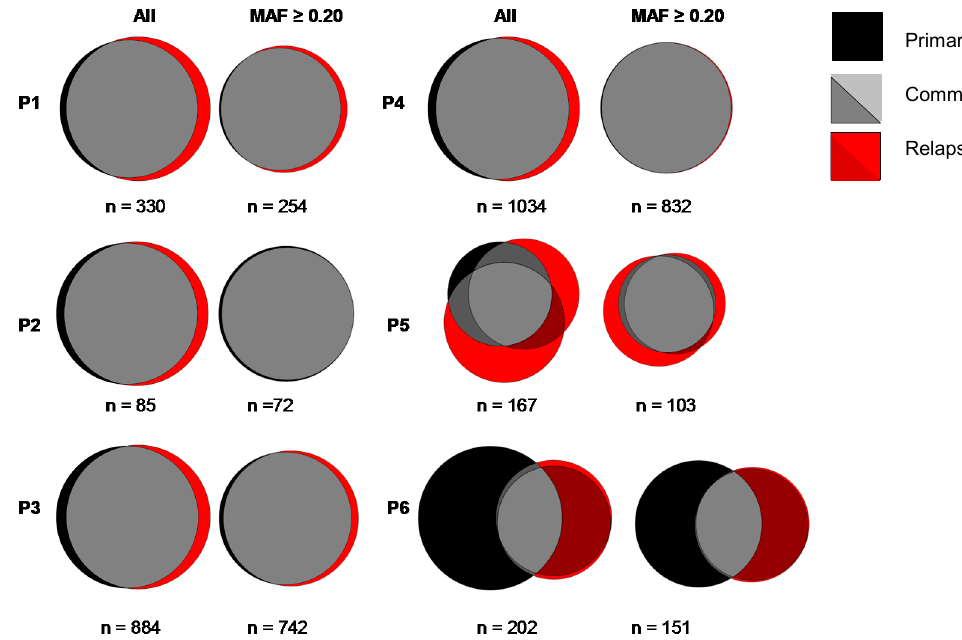
Figure 2. Venn diagrams showing for each individual patient (P1–6) the overlap in mutations between primary and paired relapse tumor samples. Left panels are Venn diagrams for all mutations (all), and right panels are Venn diagrams for mutations with a mutant allele frequency (MAF) ≥ 0.2. The total numbers of mutations per patient are depicted below each diagram. The size of the relapse diagram is proportional to the primary sample. In the patients with two biopsies at relapse (P5 and P6), the concordance between the novel mutations in the relapse samples was 45.3% and 89.2%, indicative of spatial heterogeneity.